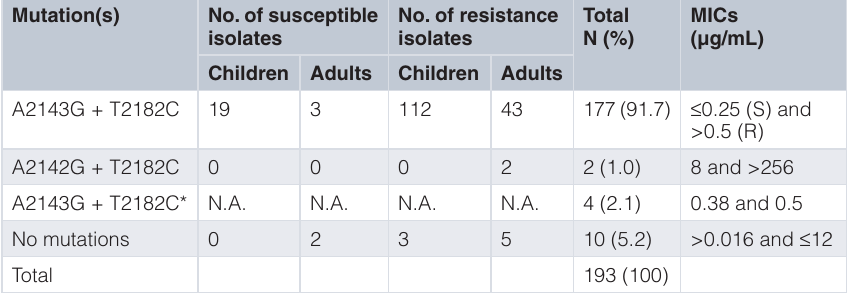
Table 2. Minimum inhibitory concentration values and 23S rRNA mutations of clarithromycin-susceptible and -resistant isolates. Mutation(s) No. of susceptible